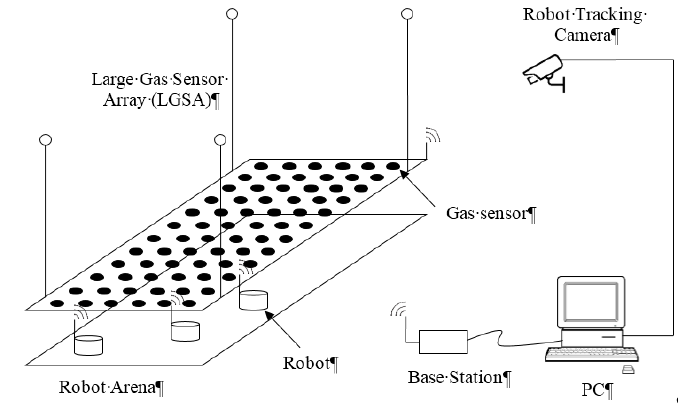
Figure 1. Overview of the testbed system.